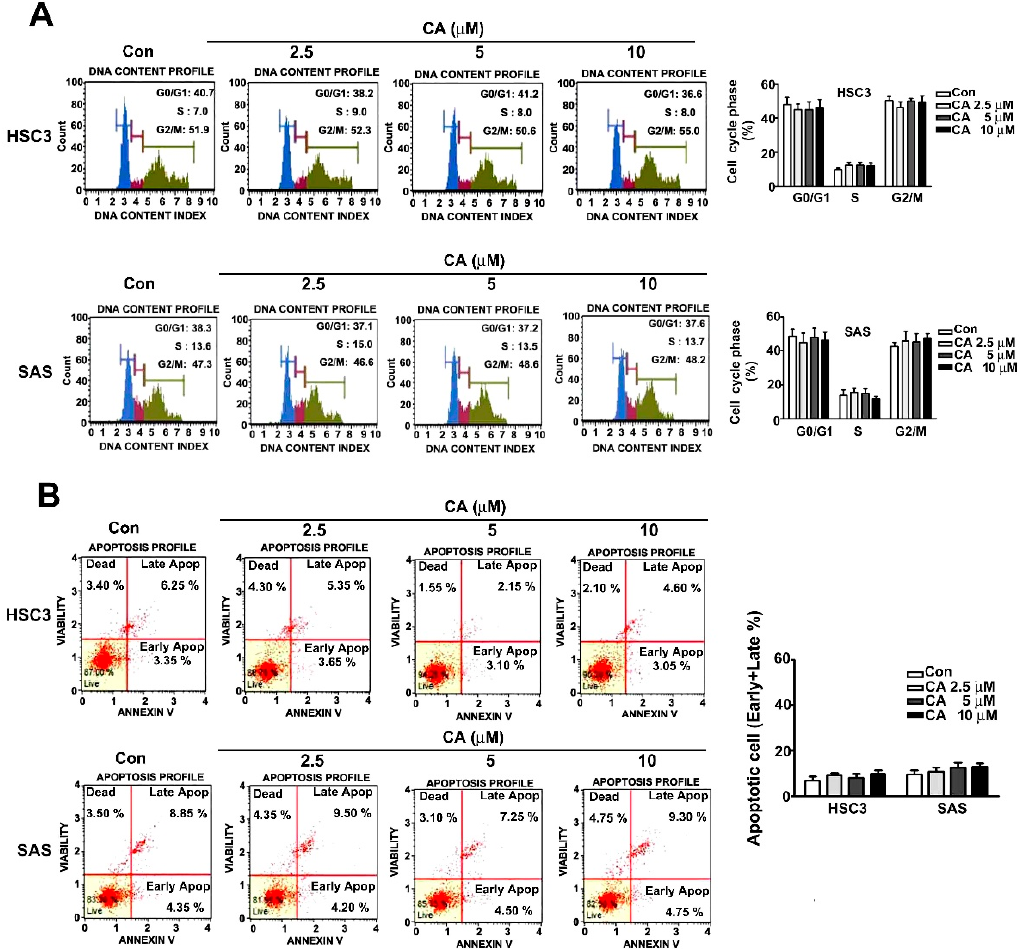
Figure 2. Effect of CA on cell cycle arrest and apoptosis induction in human HSC3 and SAS OSCC cells. ( A ) The regulation of cell cycle distribution was analysed using PI staining by flow cytometry. ( B ) Apoptosis induction in human HSC3 and SAS cells exposed to various concentrations (0, 2.5, 5 and 10 μ M) of CA by Annexin V/PI staining through flow cytometry. (Mean ± SE, n = 3). Control: untreated cells.